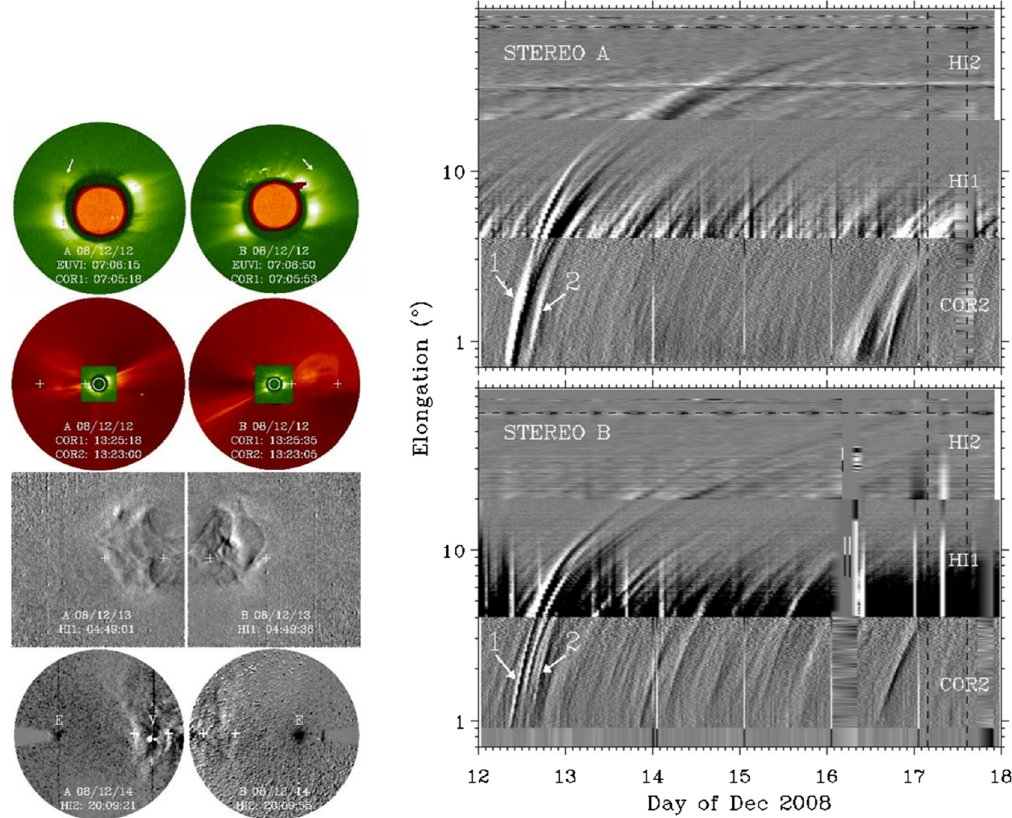
Figure 3. STEREO observations of 12 December 2008 CME/ICME event. The left column shows the CME/ICME evolution observed by STEREO A ( left ) and STEREO B ( right ). From top to bottom, the panels display the composite images of EUVI at 304 Å and COR1, showing the nascent CME (indicated by the arrow), combined COR1 and COR2 images of the fully developed CME, and running difference images from HI1 and HI2 when the ICME is far away from the Sun. The crosses mark the locations of the CME leading and trailing edges obtained from the time–elongation map. The positions of the Earth and Venus are labelled as E and V. Right: time–elongation maps constructed from running difference images of COR2, HI1 and HI2 along the ecliptic plane for STEREO A ( upper ) and B ( lower ). The arrows indicate two tracks associated with the CME. The vertical dashed lines show the MC interval observed at wind, and the horizontal dashed line marks the elongation angle of the Earth [84].